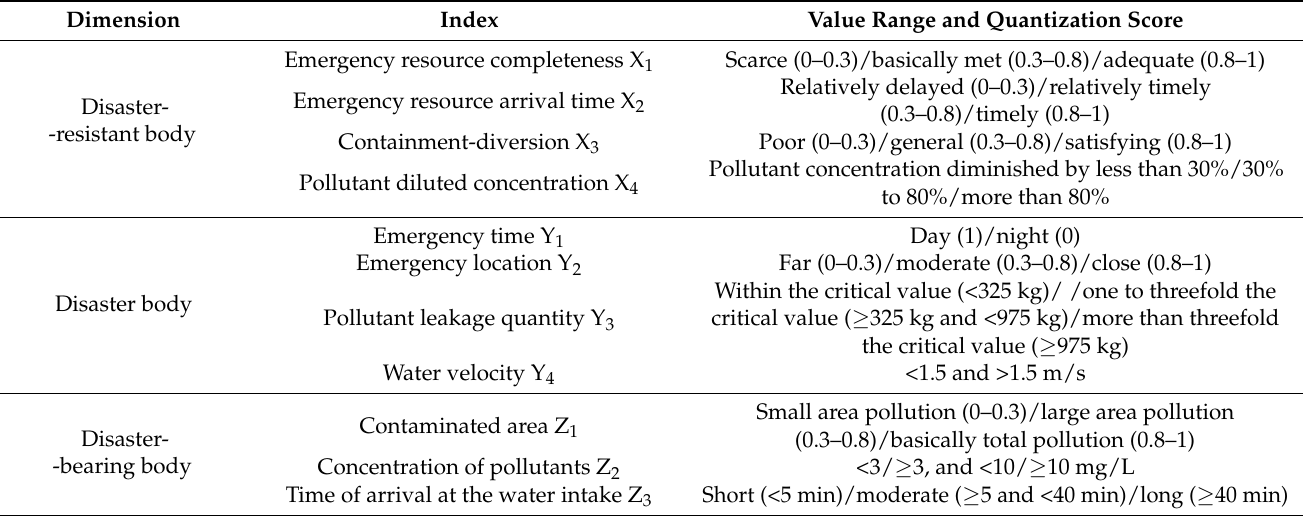
Table 6. Scenario network node variables and values of “4.25 event”.